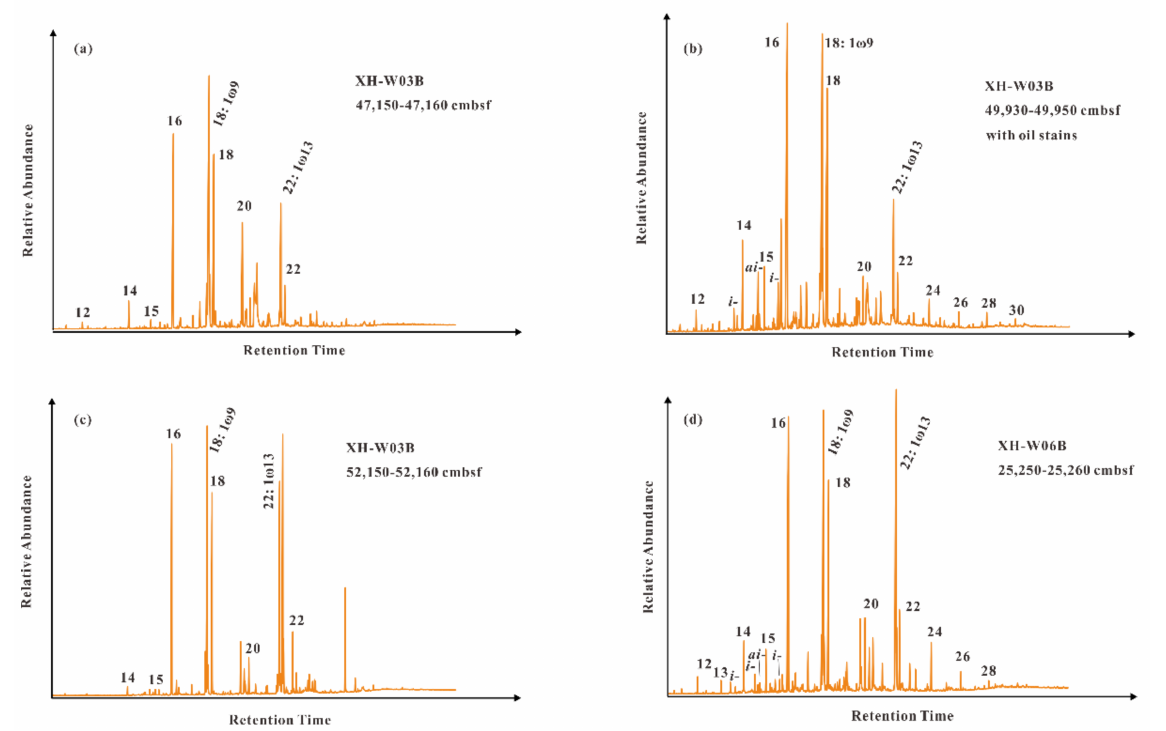
Figure 5. GC-MS chromatograms showing the distribution of fatty acids in sediments from ( a – c ) core GMGS4-XH-W03B and ( d ) core GMGS4-XH-W06B. Arabic numerals denote the numbers of carbon atoms. 18:1 ω 9 and 22:1 ω 13 refer to C 18:1 ω 9 and C 22:1 ω 13 mono-unsaturated fatty acids. The symbols i- and ai- represent iso -C 14:0 , iso -C 15:0 , anteiso -C 15:0 , and iso -C 16:0 , respectively.